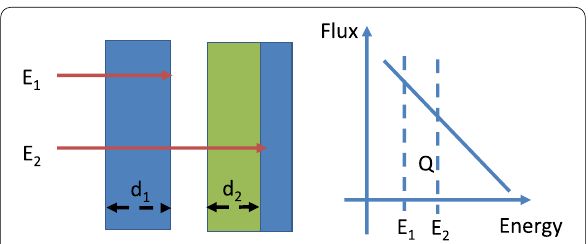
Fig. 9 (left) Simple structure model for internal charging. The thicknesses of the satellite shield ( d 1 ) and target material ( d 2 ) will be provided upon request. (right) Charge ( Q ) of the d 2 region calculated from energy